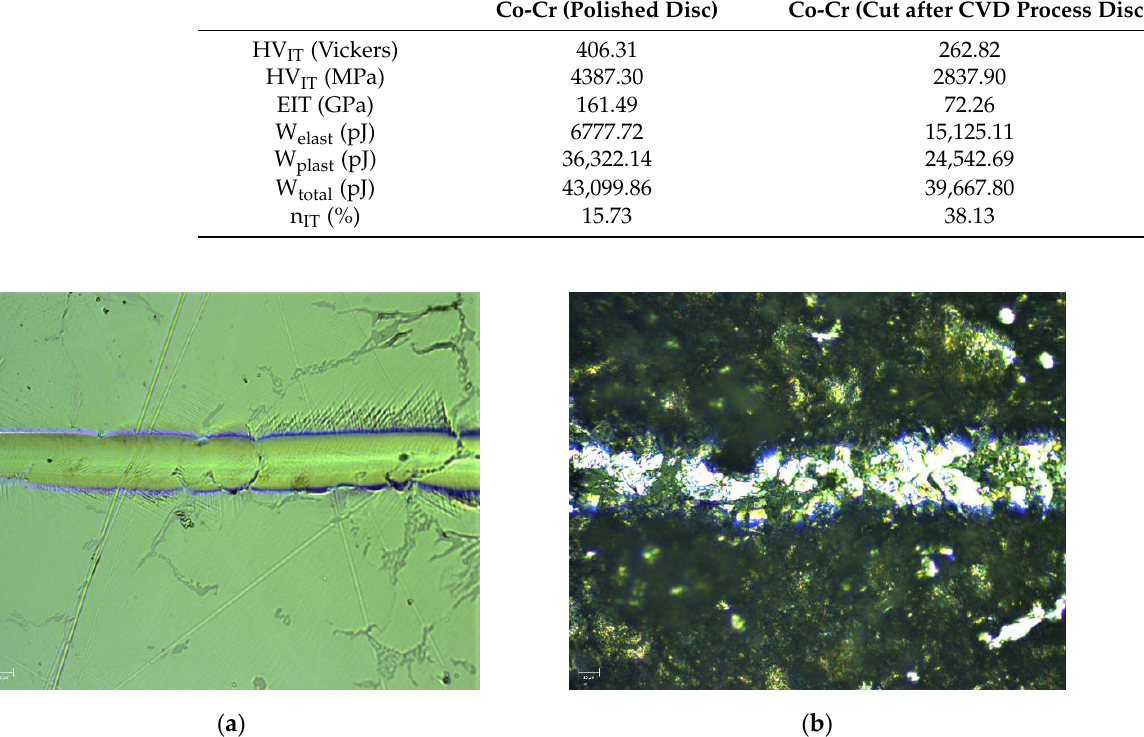
Co-Cr (Polished Disc) Co-Cr (Cut after CVD Process Disc) Table 2. Mechanical properties as instrumental hardness (HV IT ), instrumental elastic modulus (E IT ), elastic deformation energy (W elast ), plastic deformation energy (W plast ), total deformation energy (W total ), and elastic deformation energy to total energy ratio W elast /W tot (n IT ) for Co-Cr discs.